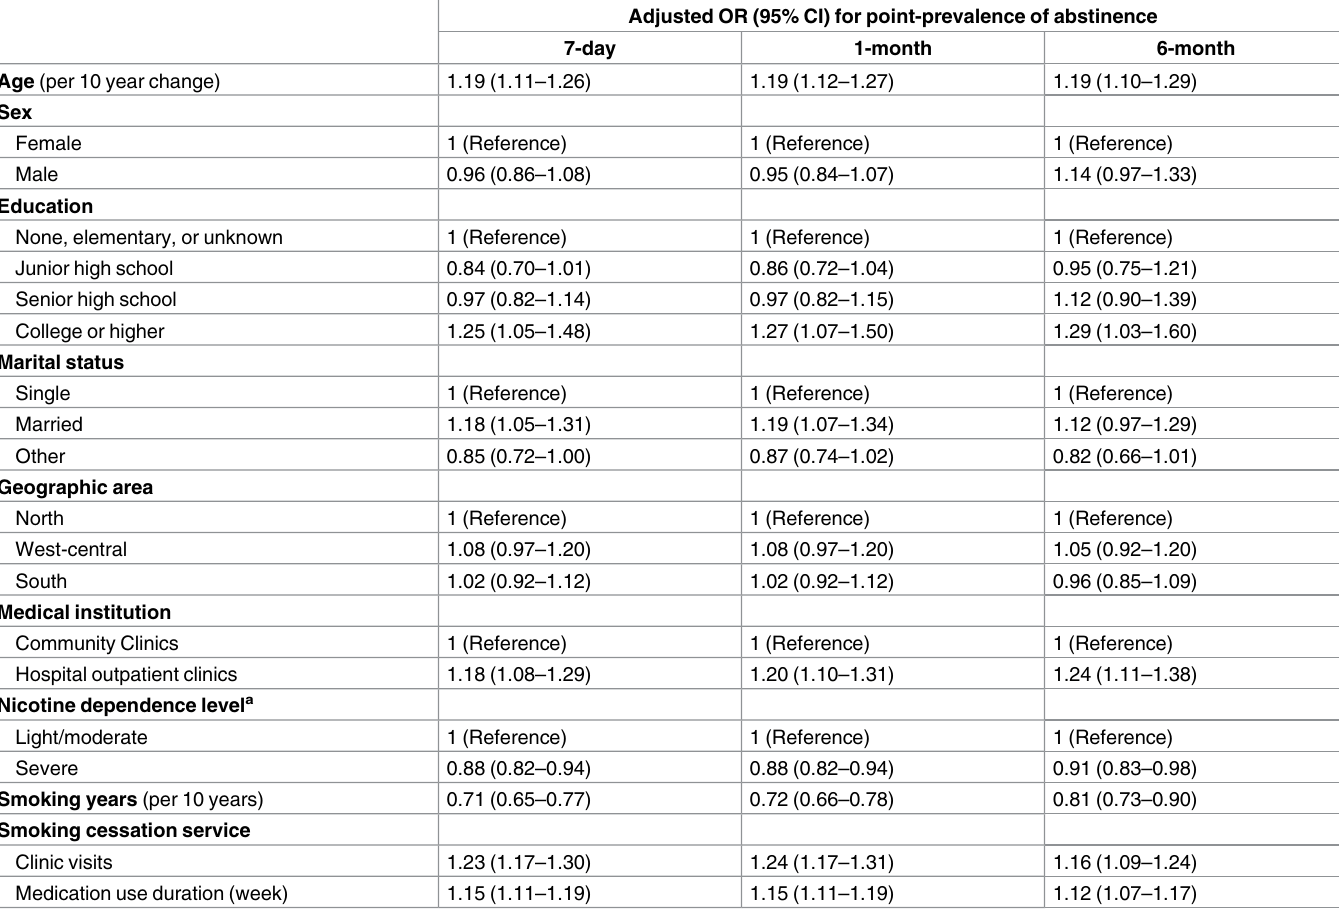
Table 2. Multivariable-adjusted OR (95% CI) for 7-day, 1-month or 6-month point-prevalence of abstinence after 6 months in relation to baseline